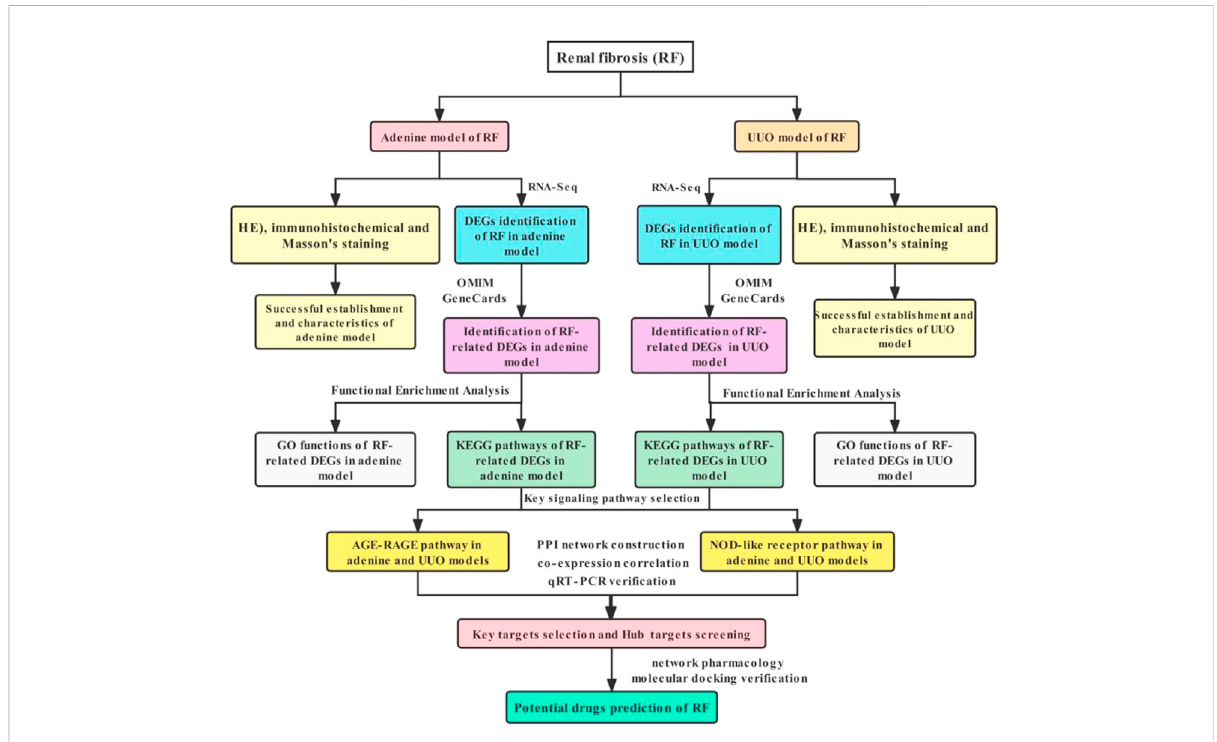
FIGURE 1 Work fl ow of exploring molecular mechanisms of RF based on RNA-Seq, bioinformatics, network pharmacology and molecular docking methods, including the adenine and UUO